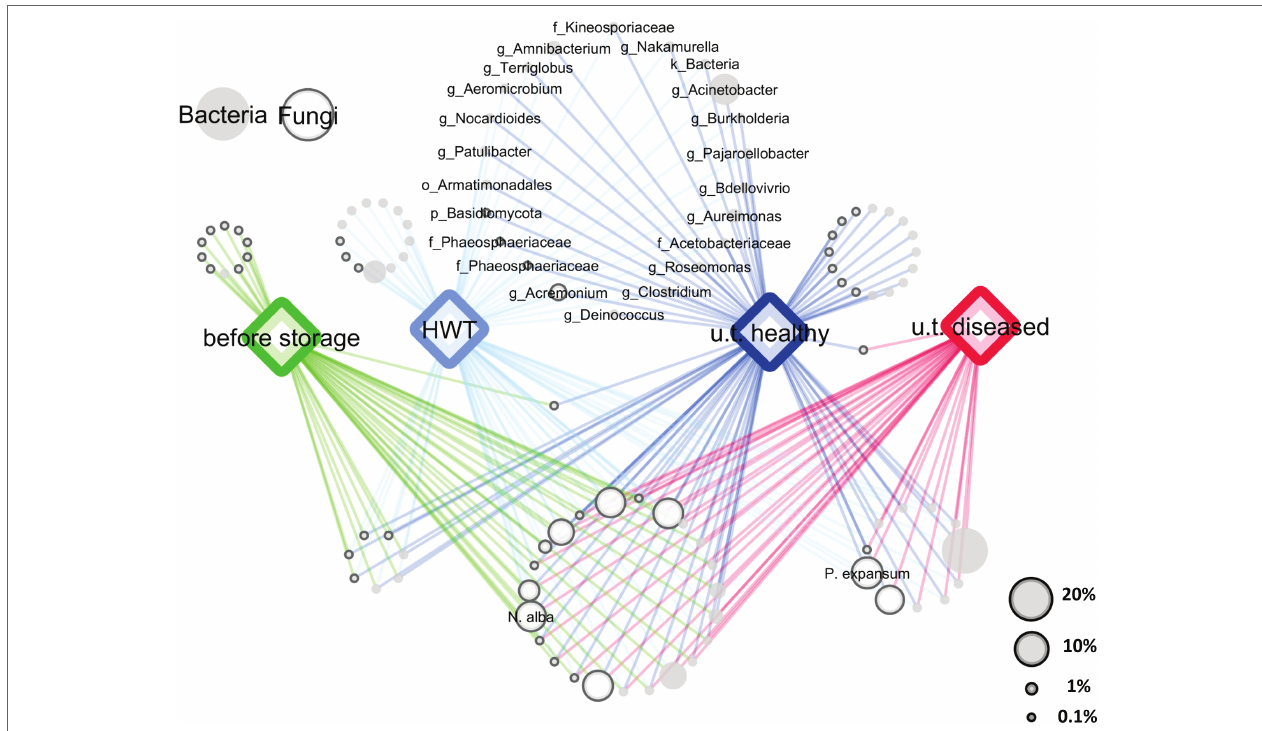
FIGURE 1 | Core and specific microbiota for the four apple groups. Core bacterial and fungal microbiota (taxa occurring in 50% of all replicates) of the four groups “before storage”, “HWT”, “untreated healthy” (u.t. healthy) and “untreated diseased” (u.t. diseased) were combined for network analysis. Node size corresponds to relative abundance in the dataset as described in the legend on the lower right. Node color indicates bacteria (filled light gray) and fungi (outlined dark gray), as shown in the legend on the upper left. Nodes of taxa shared by healthy stored apples, indicating the healthy postharvest microbiota, are labeled where the label prefixes k_, p_, o_, f_ and g_ denote for kingdom, phylum, order, family and genus, respectively. Taxonomy of the two postharvest pathogens N. alba and P. expansum was assigned on species level using the NCBI BLAST alignment